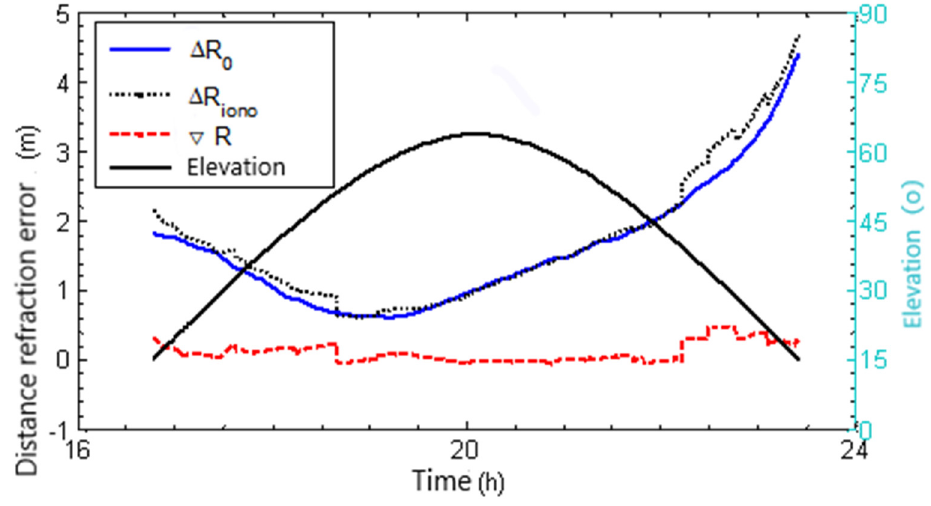
Figure 4. Analysis of the correction effect by the self-adaptive grid method.